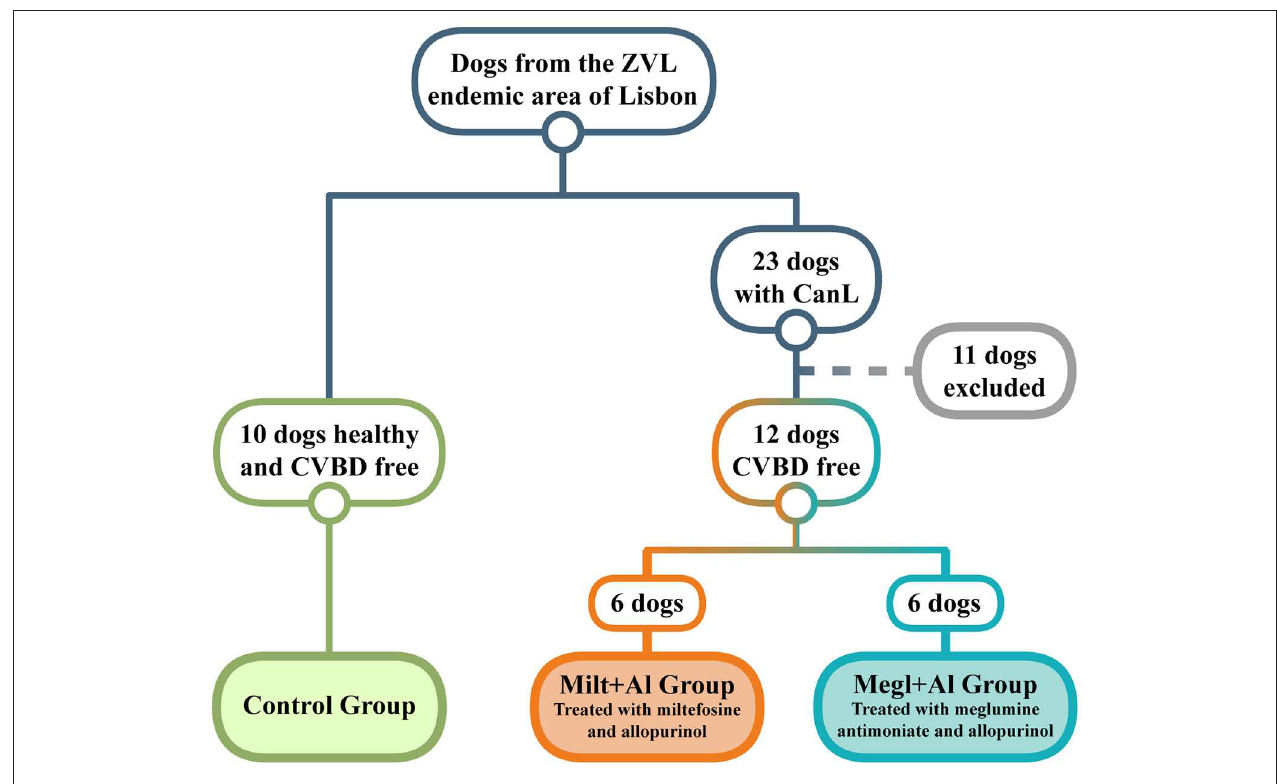
FIGURE 1 | Dog selection diagram used in the current study. From a population of dogs living in an endemic area of zoonotic visceral leishmaniosis (ZVL), two groups clinically diagnosed with canine leishmaniosis (CanL) were established and treated with either miltefosine in combination with allopurinol (Milt + Al) or meglumine antimoniate in association with allopurinol (Megl + Al). A group of clinically healthy dogs and free of any canine vector-borne disease (CVBD) was also selected as the control